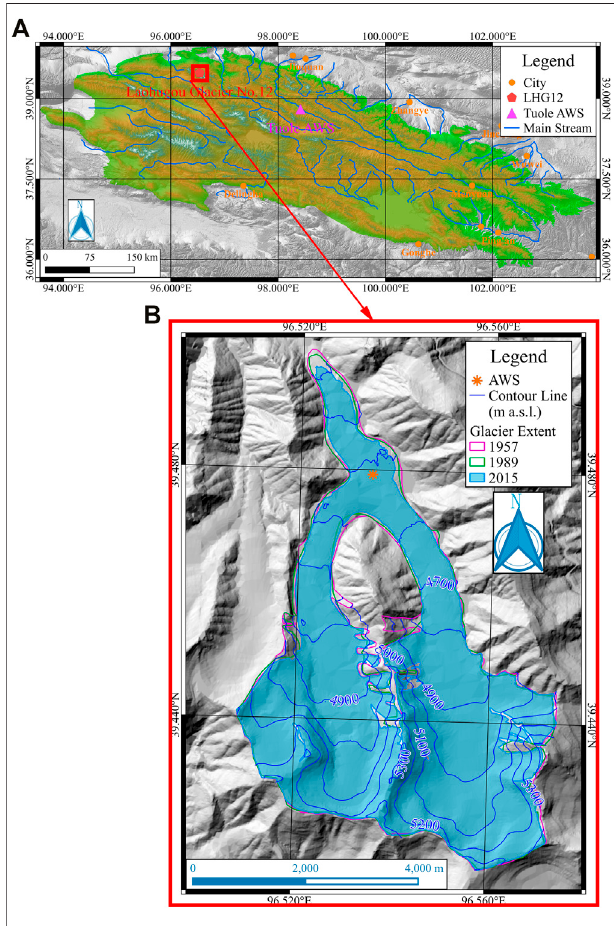
FIGURE 1 | Map of study area. (A) fi gure shows location of LHG12 and Tuole AWS in Qilian Mountains, (B) fi gure shows LHG12 extent in 1957, 1989 and 2015, surface elevation in 2015 and location of AWS at 4550 m a. s.